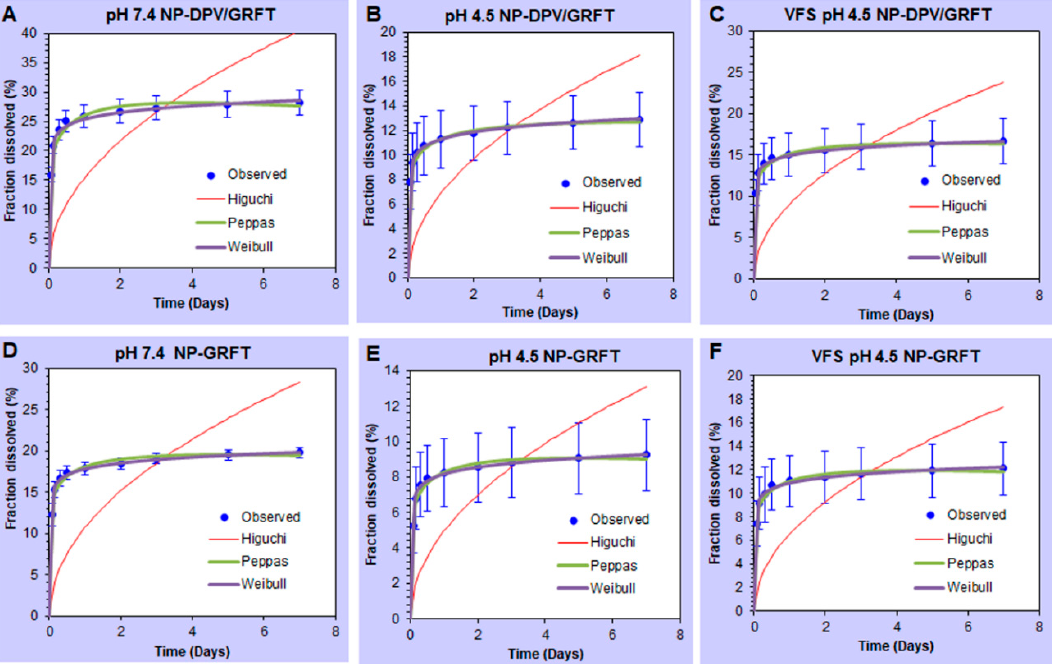
Figure 4. Mathematical model fitting of GRFT release from PLGA nanoparticles. ( A – C ) GRFT release from combination nanoparticles (NP-DPV/GRFT) at pH 7.4, 4.5 and VFS pH 4.5 media. ( D – F ) GRFT release from single entity nanoparticles (NP-GRFT) at pH 7.4, 4.5 and VFS pH 4.5 media. Dissolution profiles were fitted to Higuchi, Peppas, and Weibull models.